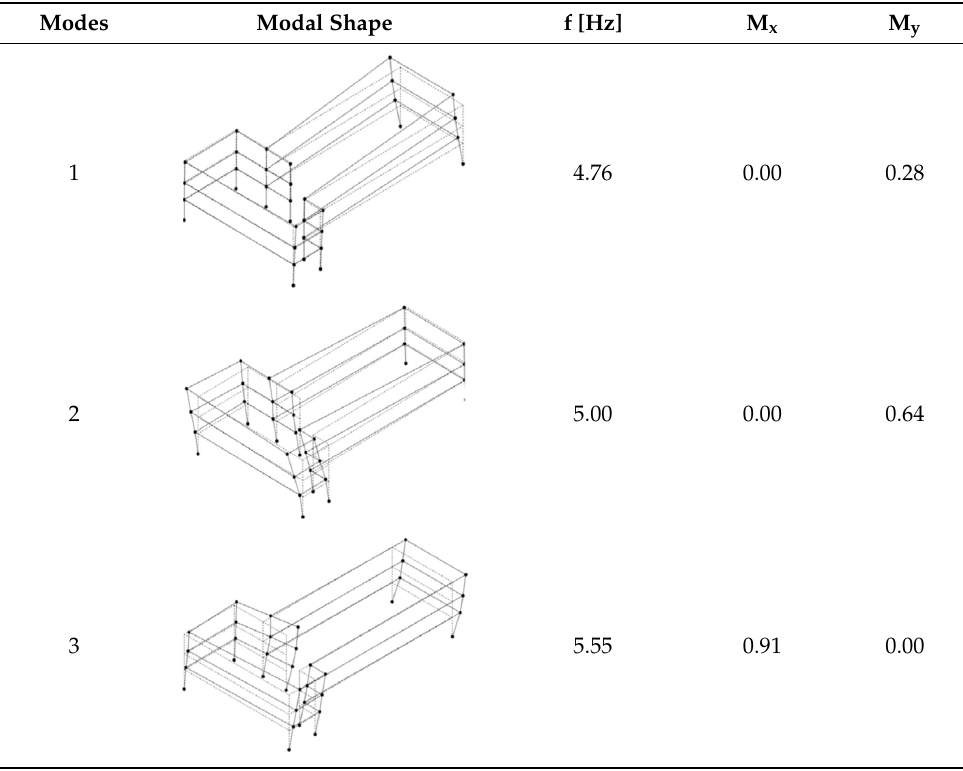
Figure 12. View of the two Case Studies ( a ) CS1 and ( b ) CS2 [39].